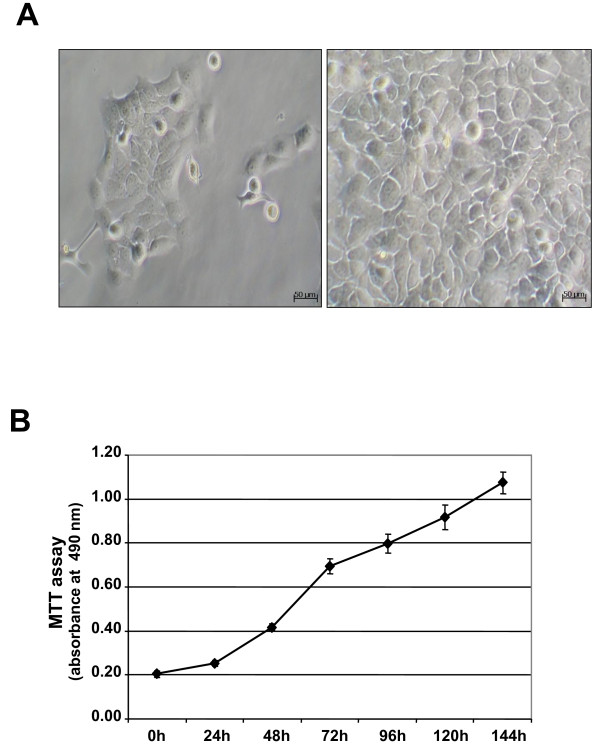
Cell morphology and growth characteristics of PaCa 5061 cells. 1A. Morphological examination of non-confluent and confluent PaCa 5061 cells by phase contrast microscopy. The cells grew in a monolayer with polygonal shape, epithelial morphology and large nuclei. 1B. Growth curve of PaCa 5061 in culture. Proliferation of cells (1000/well) was determined every 24 hours and relative growth rates were analyzed over time (0-144 h) by MTT assay. The results shown are for an experiment representative of three independent assays.